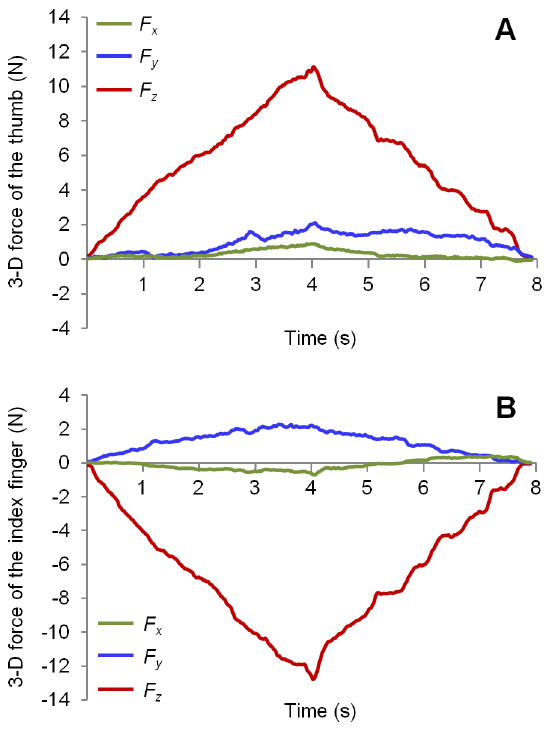
Figure 3. Force vector components of the thumb and index finger from one representative trial. (A) The F x , F y and F z components of the thumb force vector; (B) The F x , F y and F z components of the index finger force vector.